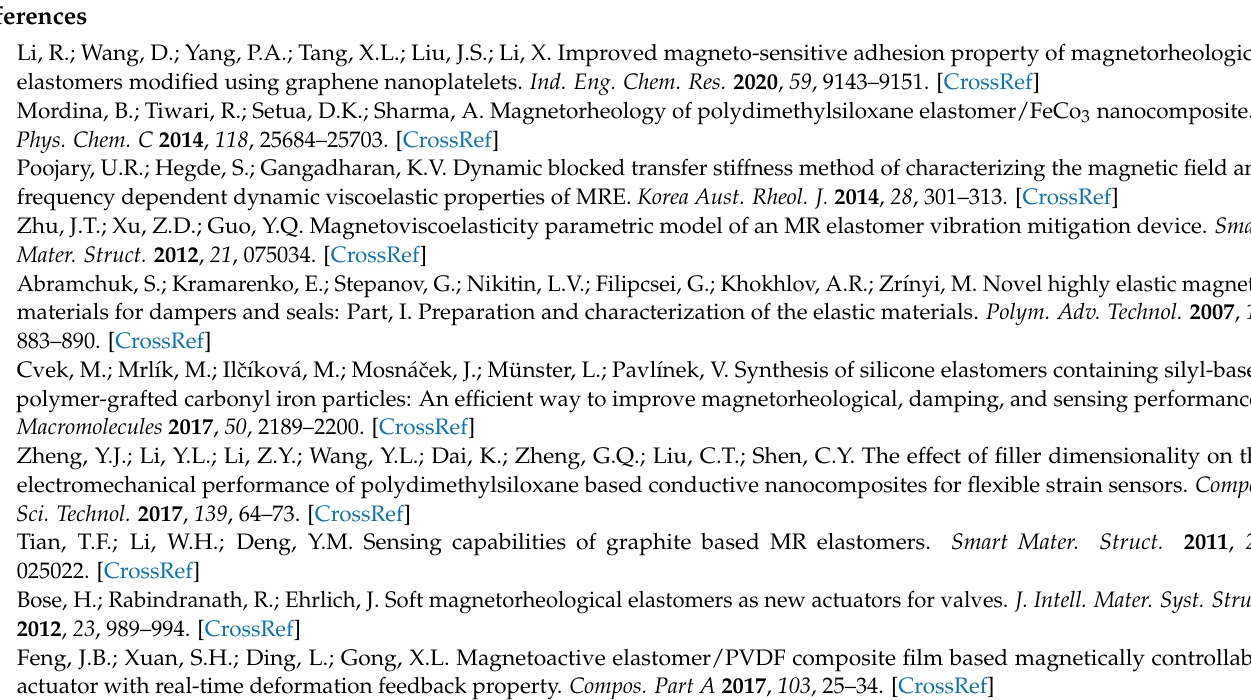
Figure S2: The loss modulus of the GO-filled PDMS-based MREs tested by the frequency sweeps under the zero-field and the magnetic